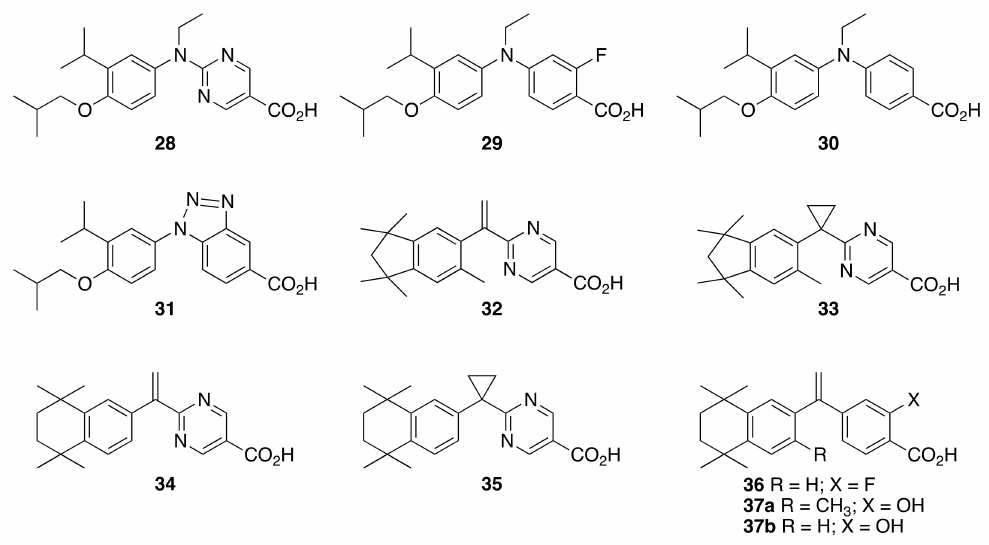
Figure 3. Structures of novel target rexinoids 28 – 36 , 37a , and 37b